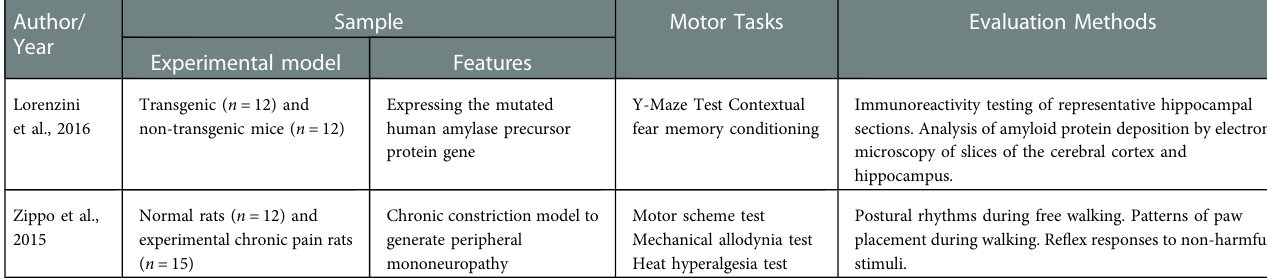
TABLE 4 Characterization of the experimental studies included in relation to the sample, motor tasks and evaluation methods.